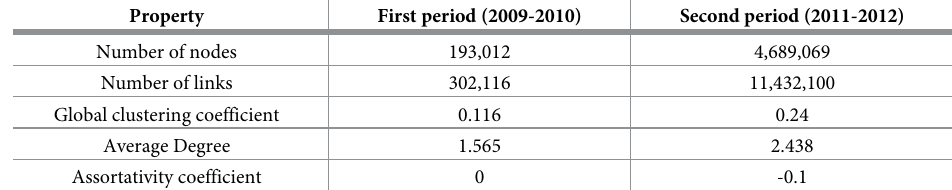
Table 2. Basic properties calculated for the static bitcoin network in the first and second period. An increased number of links and nodes in the second period shows that the bitcoin network had grown significantly by 2013. A larger clustering coefficient in the late period indicates a higher connectivity of the system users. The average degree also increased in the late period, showing that the system had become more popular as each node tended to create more connections in comparison to the first period (where most of the nodes transacted only a few times).